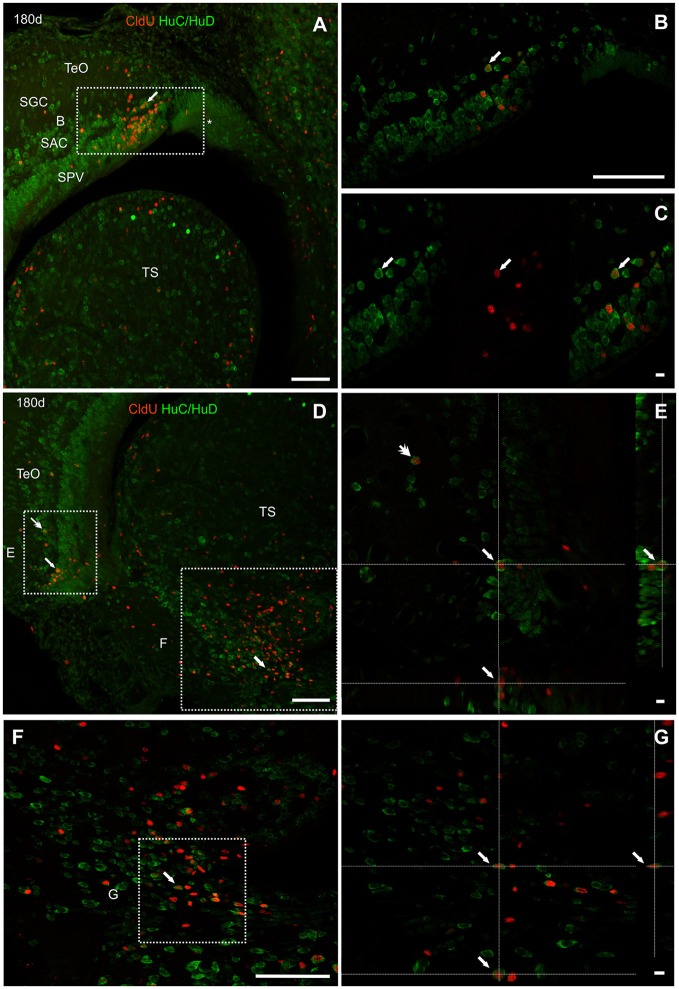
Neuronal differentiation in the intermediate region of the optic tectum and torus semicircularis at 90 and 180 days after four daily injections of CldU demonstrated by co-localization with HuC/HuD. (A,B) Low power microphotographs at the dorsal-medial and ventral-lateral border of the tectum opticum (TeO) and dorsal region of the torus semicircularis (TS), rostral to the caudal pole. The dotted rectangles indicate the location of three regions of interest observed at higher magnification in (B,E,F), respectively. Double labeling of tectal cells (B,C,E) and toral newborn cells (F,G) was confirmed by the overlay of each channel (C) and xy and zy orthogonal projections a stacks. Scale bars: (A,B,D,F) 20 μm; (B, Inset in A and D) 100 μm; (C,E,G) 5 μm.